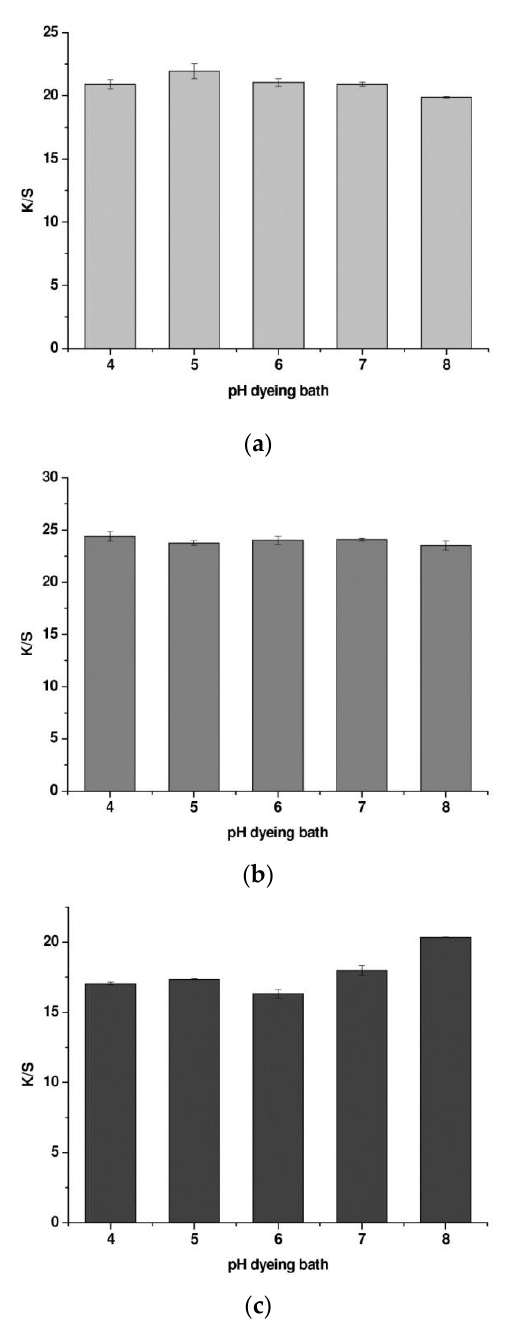
Figure 7. Effect of dye bath pH on the color yield (K/S) of bicomponent filaments dyed with: ( a ) Dye Figure 7. E ff ect of dye bath pH on the color yield (K / S) of bicomponent filaments dyed with: ( a ) Dye #H; ( b ) Dye #M; ( c ) Dye #L (Temperature = 130 °C, Concentration of carrier = 0 g/L, Time = 50 min). #H; ( b ) Dye #M; ( c ) Dye #L (Temperature = 130 ◦ C, Concentration of carrier = 0 g / L, Time = 50